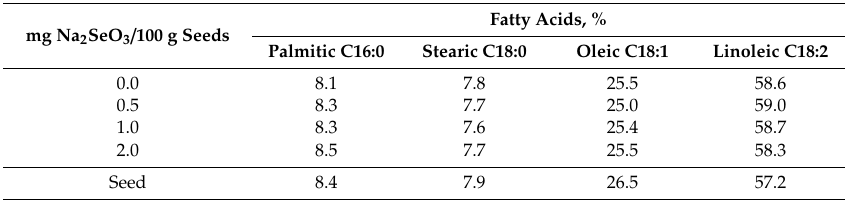
Table 2. Fatty acid composition (% w / w ) of chickpea oils extracted from sprouts germinated for four days with di ff erent levels of sodium